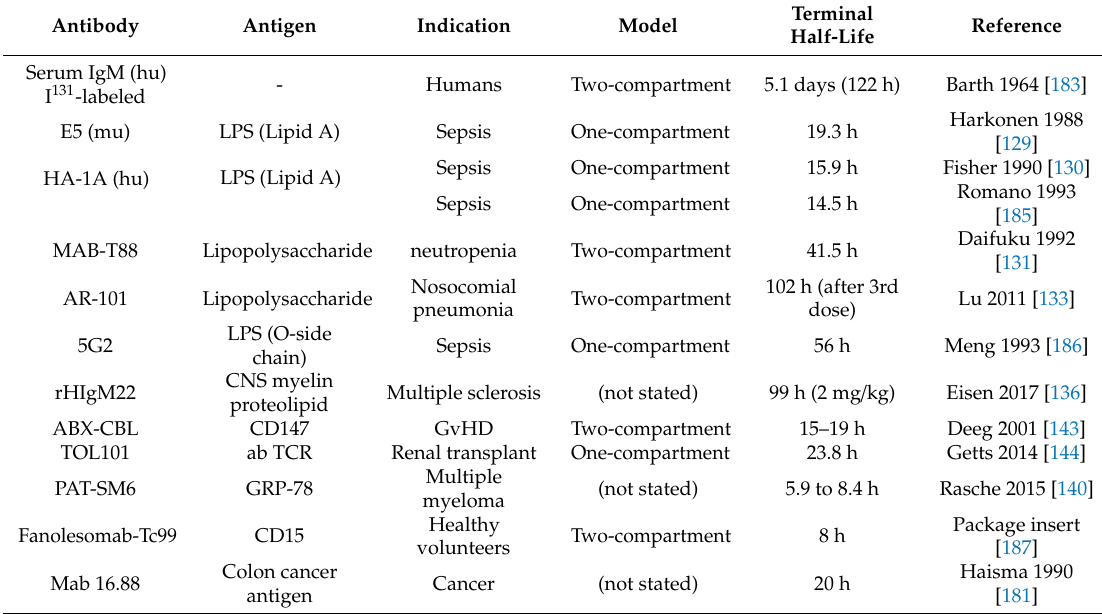
Table 4. Pharmacokinetics of IgM antibodies in